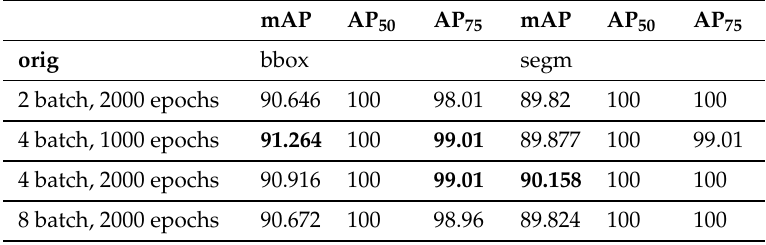
Table 4. Training results for TensorMask pre-trained learning and 200